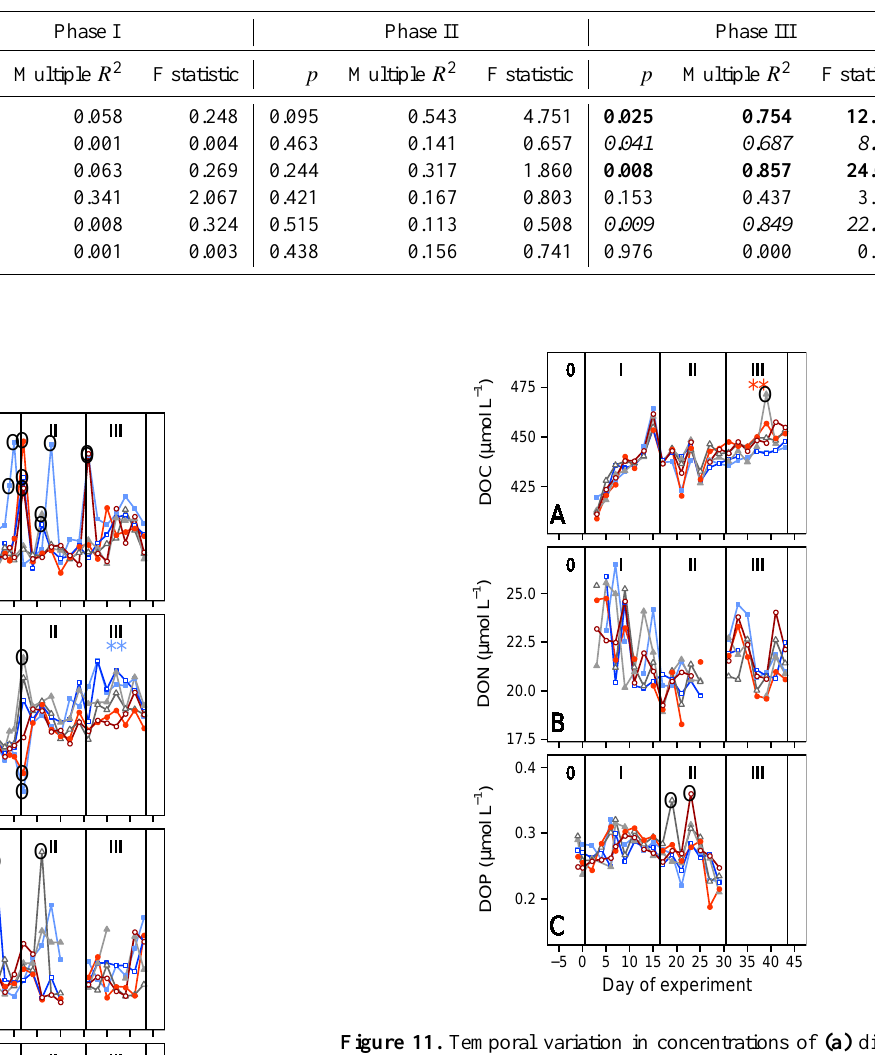
Figure 11. Temporal variation in concentrations of (a) dissolved organic carbon, (b) dissolved organic nitrogen, and (c) dissolved organic phosphorus. CO 2 treatments are indicated by colours and symbols described in Table 1. Red asterisks denote a statistically significant positive effect of CO 2 (** = p <0.01). Outliers (Grubb’s test; see methods) are indicated by black circles and were excluded from linear regression